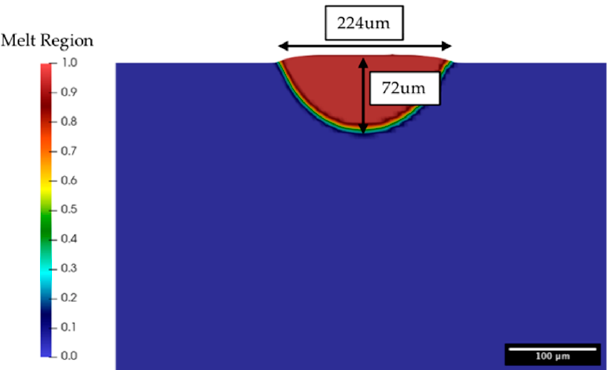
Figure 10. Cross-section of 82 W spot-melt scenario, showing maximum melt region predicted by FLOW-3D and the resulting melt pool depth and width.